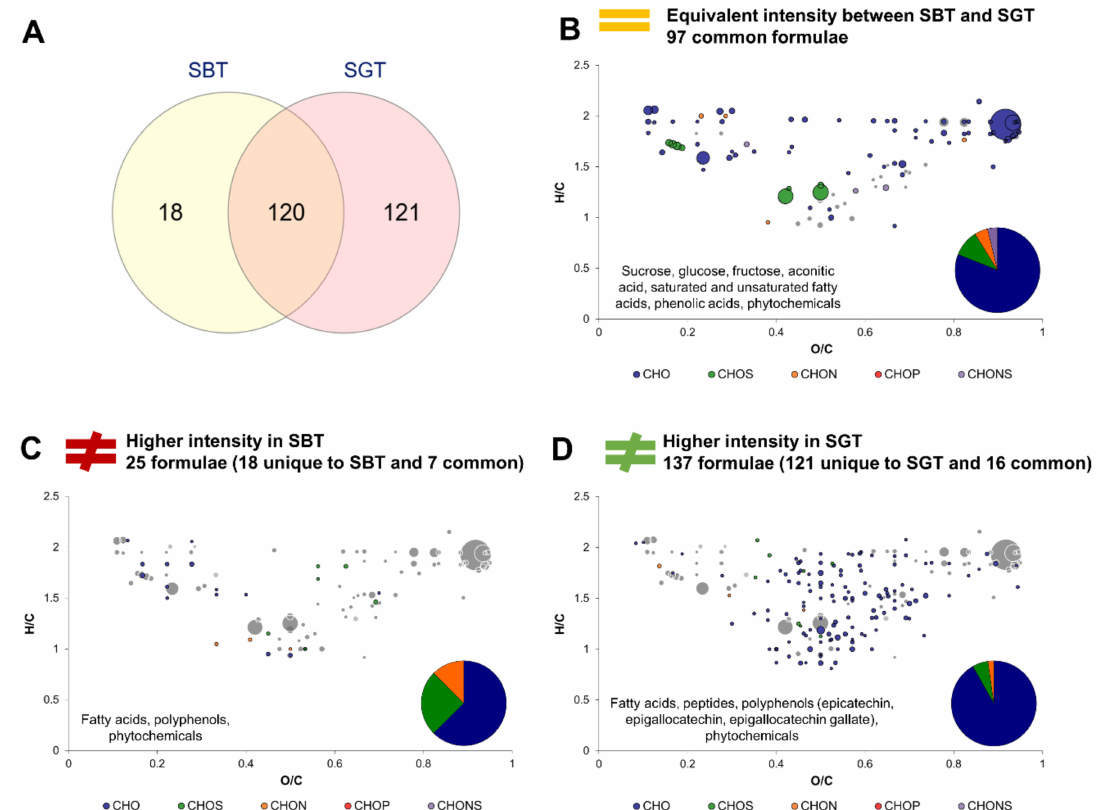
Figure 5. Comparison of composition between Sugared Black Tea (SBT) and Sugared Green Tea (SGT). ( A ) Venn diagram of formulae identified in SBT and SGT. Van Krevelen diagrams and putative identities of formula ( B ) equivalent in intensity in both conditions, ( C ) higher in SBT and ( D ) higher in SGT. The surface of bubbles expresses relative formulae intensity. Core metabolites formulae (Figure 2B) are represented in the background in